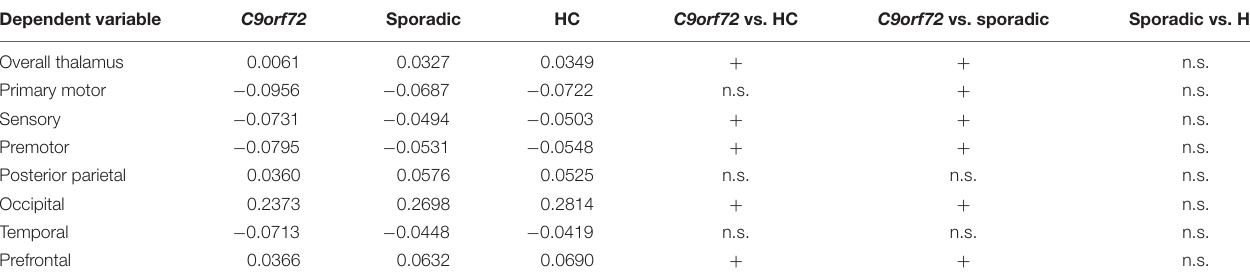
TABLE 3 | Laterality indices of overall thalamus and thalamic subregions, and pairwise post hoc Bonferroni test results. Dependent variable